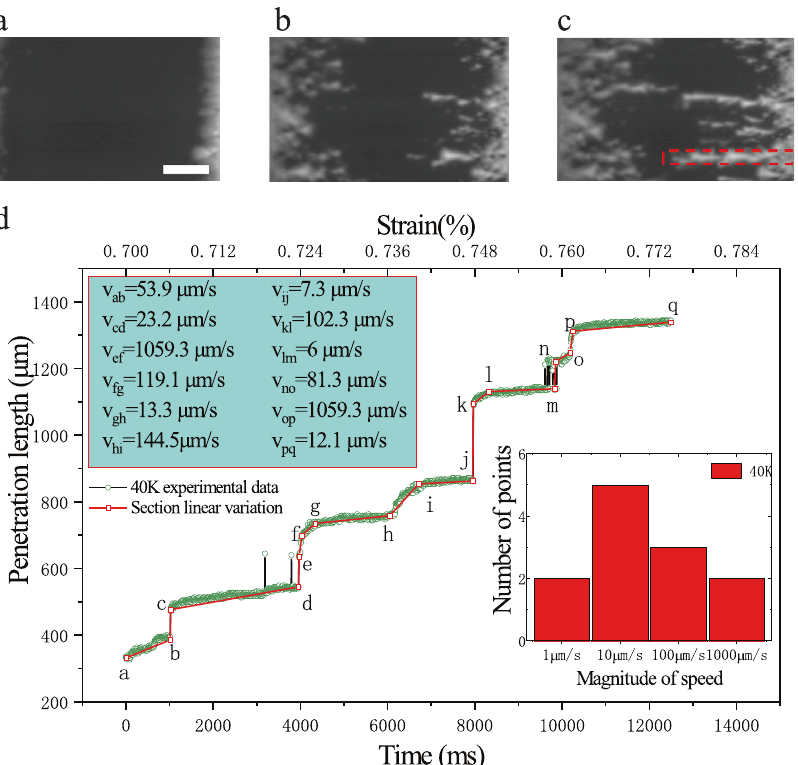
Fig. 5 The characteristic curve of fl ux penetration length versus loading time. a – c Flux evolutions at 0, 8150, and 12,500 ms, respectively. Here, the scale bar is 500 μ m. d Penetration length in the region marked by a red rectangle in ( c ) depends on the loading time. Some jumping stages are observed, and the average speeds for each continuous section from the red curve are calculated. The inserted is their magnitude distribution.